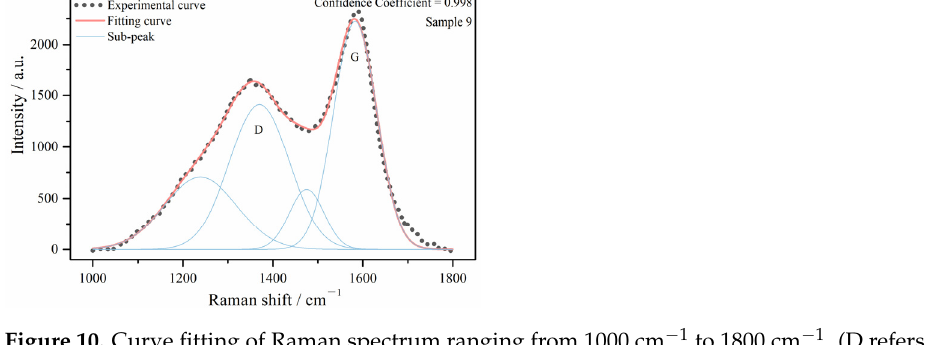
Figure 10. Curve fitting of Raman spectrum ranging from 1000 cm − 1 to 1800 cm − 1 . (D refers to the D band, and G refers to the G band).